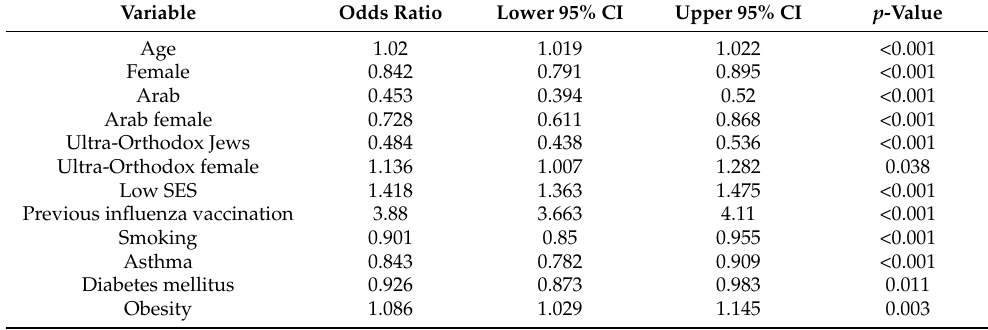
Table 5. Multivariate analysis of variables associated with COVID-19 vaccination rates.